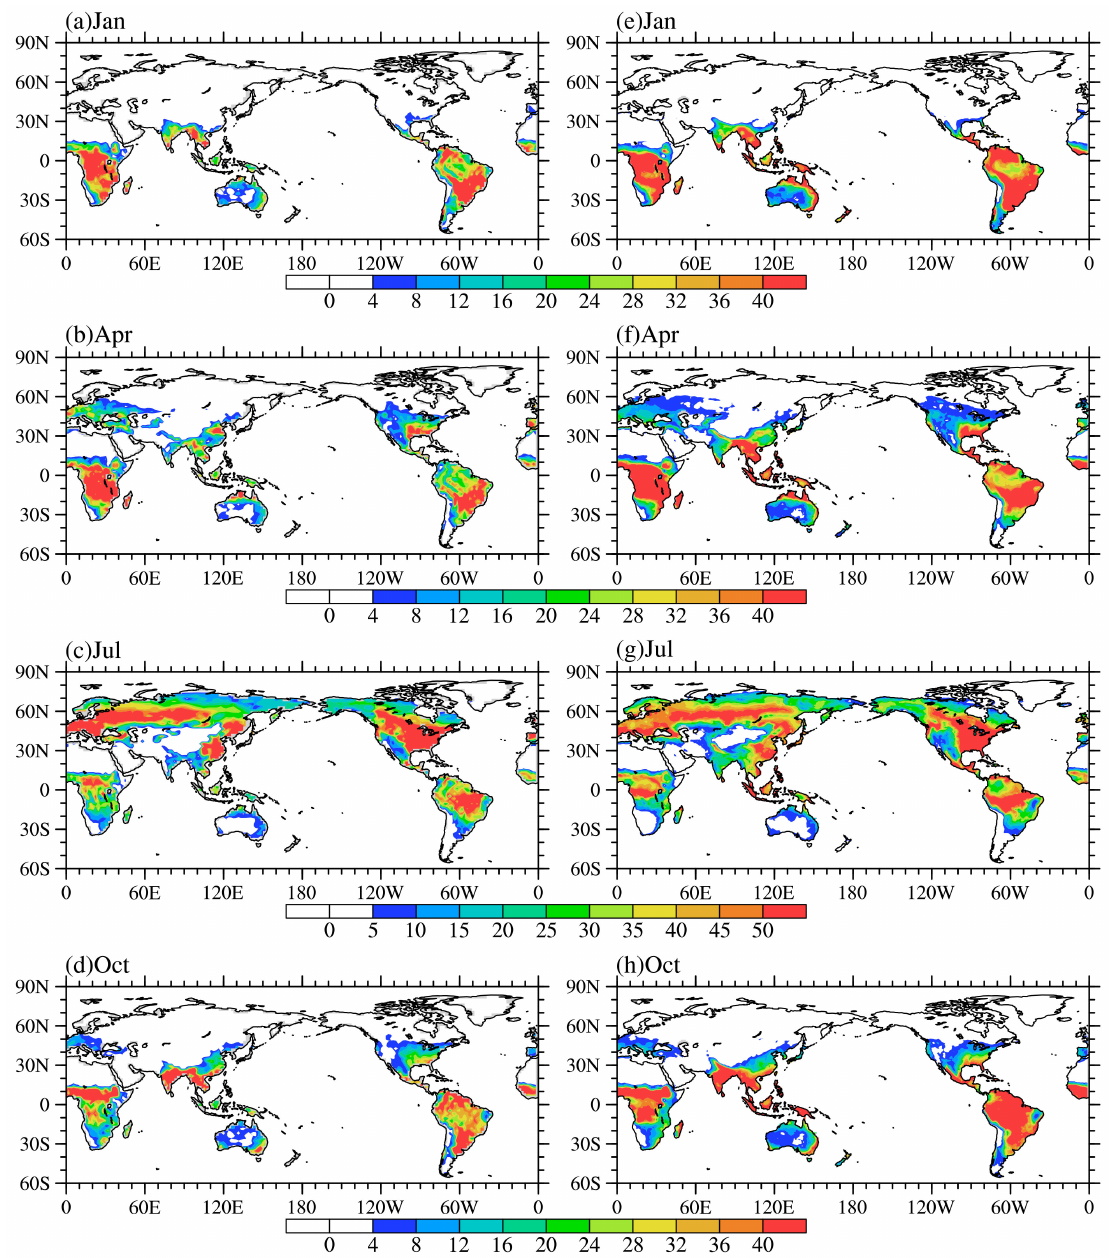
Figure 6. Spatial distribution of global Et (units: W/m 2 ): ( a – d ) NOAA reanalysis data and ( e – h ) simulated by